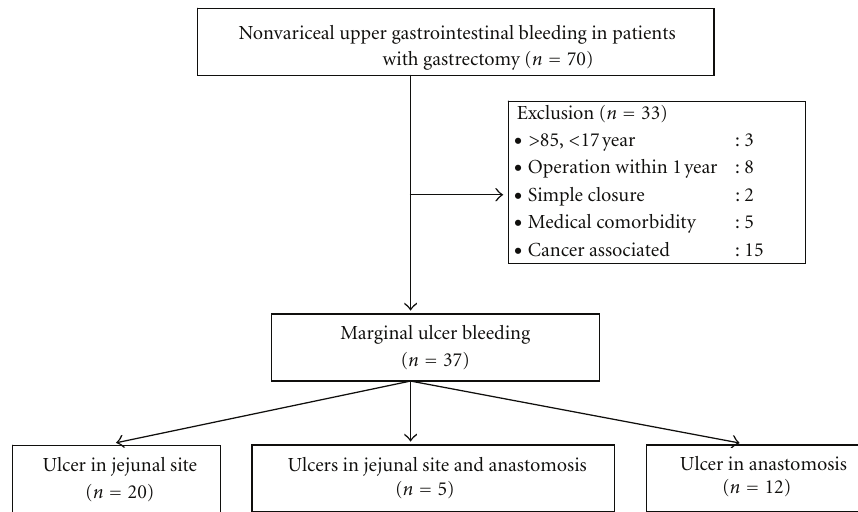
Figure 1: Study enrollment of the marginal ulcer bleeding after gastrectomy.